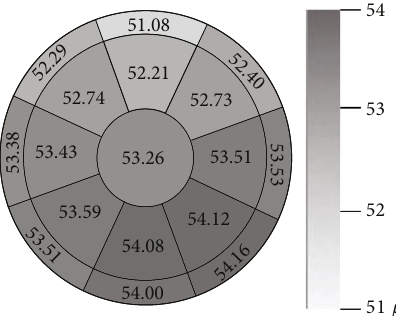
Figure 4: The distribution of corneal epithelial thickness in each sector using color gradations with average thickness on it.